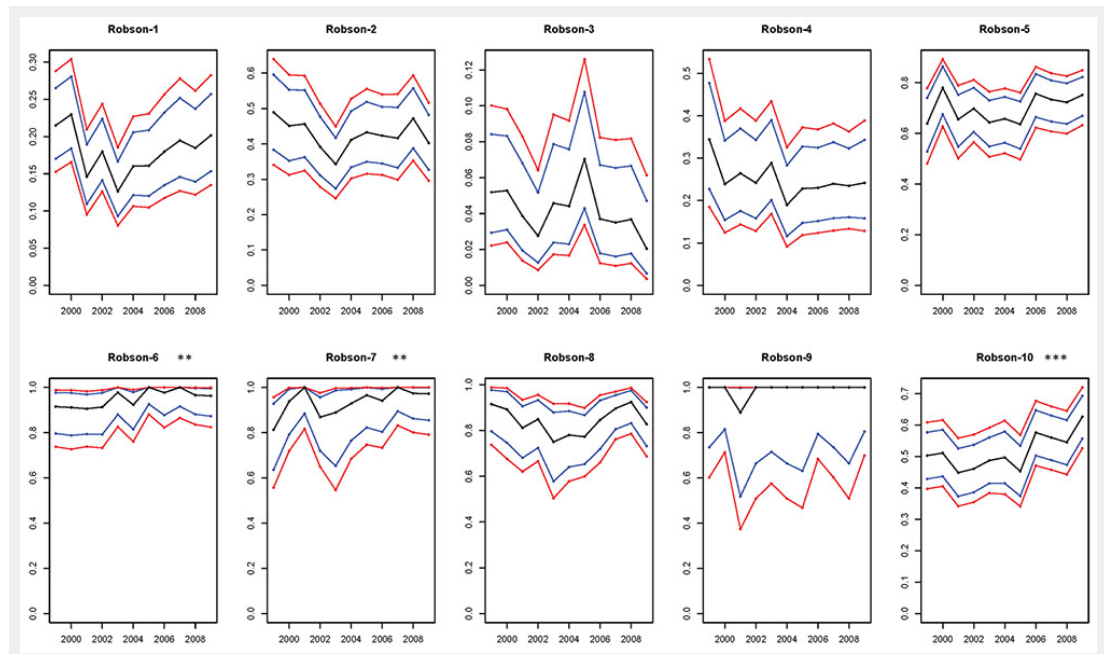
Figure 1 Change over the observation period of time in the caesarean section (CS) rate within different Robson groups. Blue lines are 95% confidence limits and red lines are simultaneous 95% confidence limits. Significant increases of the CS rate in Groups 6, 7 and 10 were detected. *p ≤0.05; **p ≤0.01; ***p ≤0.001